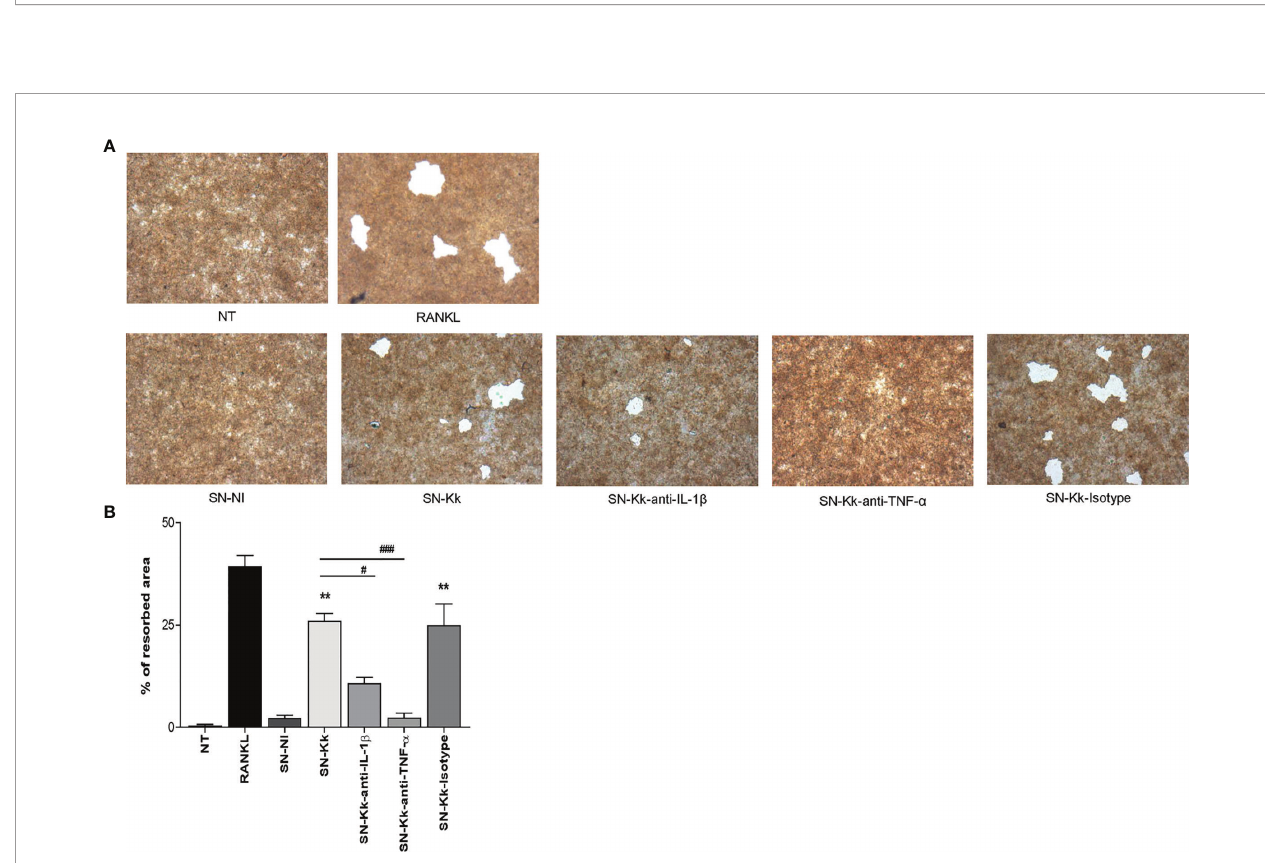
FIGURE 4 | Kingella kingae induces functional osteoclasts cells. The functional activity of K. kingae- induced osteoclasts was determined by their ability to resorb hydroxyapatite. RAW 264.7 cells were cultured on hydroxyapatite disks under the same conditions as described above. After 7 days, the cells were removed, hydroxyapatite resorption was determined by light microscopy (A) , and the resorbed area was quanti fi ed (% of resorbed area) (B) . The graphics are showing values obtained from three independent experiments. Data are given as mean ± SD. * P < 0.05; ** P < 0.01 versus cells treated with SN-NI or NT. ## P < 0.01; ### P < 0.001.